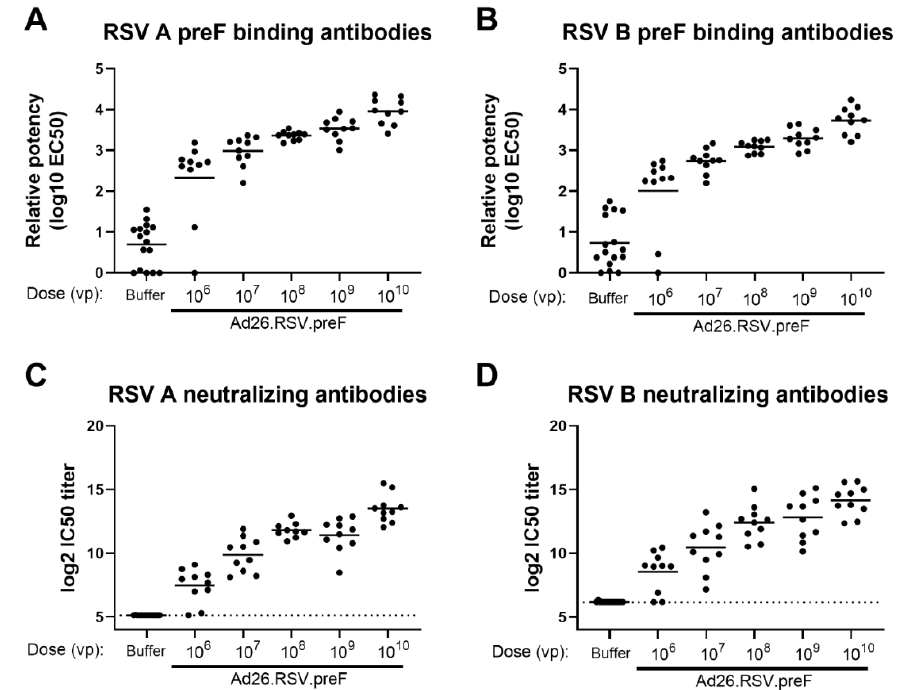
Figure 1. Ad26.RSV.preF dose-dependently induces antibodies binding to preF from RSV A and RSV B, which are capable of neutralizing both RSV A and RSV B strains in naïve cotton rats. Cotton rats were immunized with 10 6 to 10 10 vp Ad26.RSV.preF (n = 10 per group) or formulation buffer (n = 16) at day 0, and serum isolated at day 49 was analyzed. Binding IgG was determined by ELISA using RSV A preF ( A ) or RSV B preF ( B ). Neutralizing antibody titers were determined against RSV A 18-001989 ( C ) or RSV B 17-058221 ( D ) by microneutralization virus neutralization assay (MN VNA). The lower limit of detection for MN VNA was defined as the mean plus 3× the standard deviation of the formulation buffer group, indicated with a dotted line. Means per group are indicated with horizontal lines. Note: MN VNA titers against RSV A 18-001989 from one animal in the 10 8 vp dose group were unexpectedly and unexplainably high (24.2 log2 IC50), and this data point was excluded.